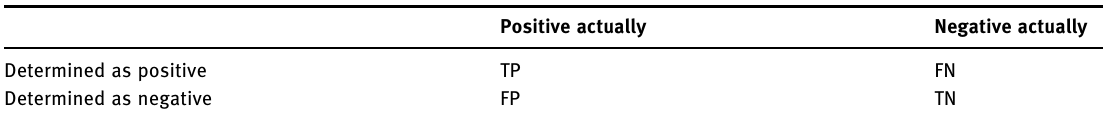
Table 1: Confusion matrix of binary classi fi